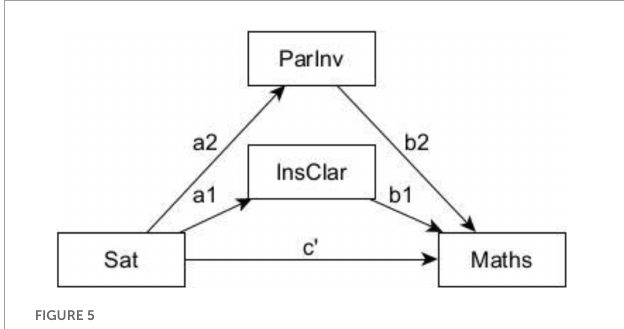
FIGURE5 Statistical model of the potential mediating effects of instructional clarity and parental involvement on the relationship between satisfaction with life and mathematics achievement. ParInv, parental Involvement; InsClar, instructional clarity; Sat, satisfaction with life; Maths, mathematics